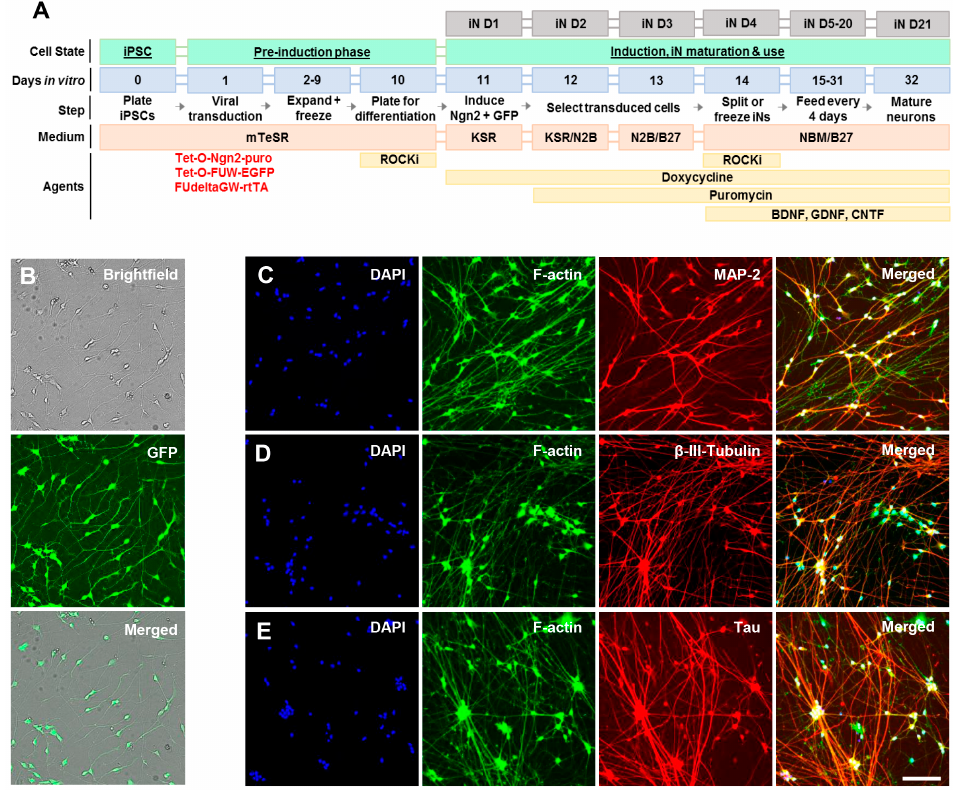
Figure 2. Neuronal differentiation of human iPSC lines. ( A ) Schematic depicting the procedure used to generate human induced neurons (iNs) from iPSCs. On day in vitro (DIV) 1, iPSCs were transduced with viruses expressing reverse tetracycline-controlled transactivator (rtTA), puromycin-resistant Neurogenin-2 (Ngn2-puro) and enhanced green fluorescent protein (EGFP). After expansion (DIV2–9), differentiation was induced with doxycycline on DIV11 (iN D1) and cells were matured for at least 23 days prior to harvesting conditioned medium (iN D23–33). ( B ) At iN D21, live cells were imaged using brightfield and FITC filters to confirm differentiation and selection. Cultures were then fixed and immunostained for DAPI, F-actin, and the neuron-specific proteins MAP-2 ( C ), β -III-Tubulin ( D ), and tau ( E ). Scale bar: 100 µm.